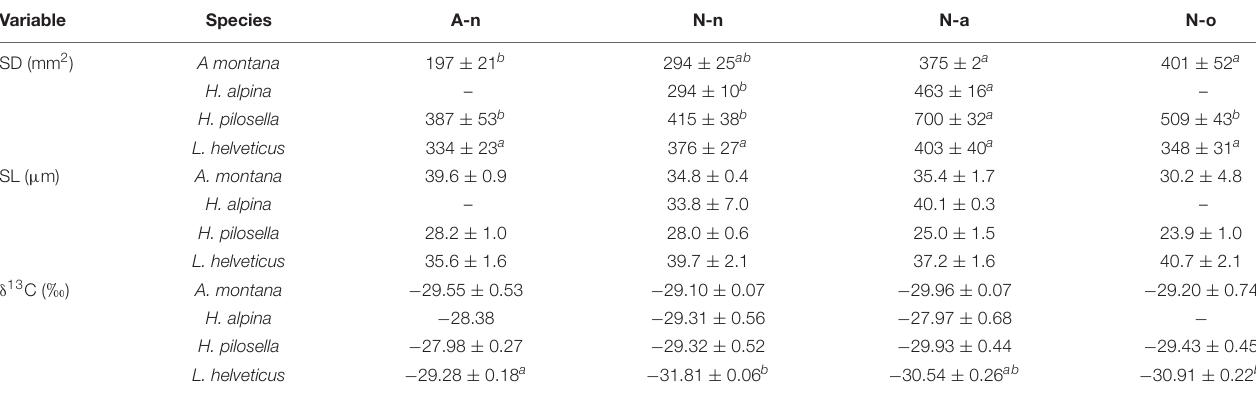
TABLE 4 | Mean ( ± SE, n = 4) values of stomatal density (SD), stomatal length (SL) and foliar stable carbon isotope discrimination ( δ 13 C) for the four species at the alpine vegetation belt (site A) on its natural soil (A-n) and at the nival vegetation belt (site N) on its natural soil (N-n), on soil originating from site A (N-a), and under the OTC (N-o). Variable Species